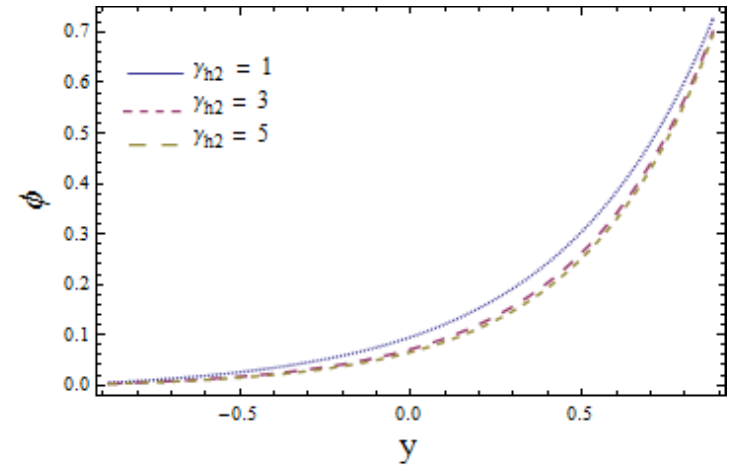
Figure 14. Mass concentration φ versus y for γ h 2 when (cid:101) = 0.2, τ ∗ = 2, x = 0.1, t = 0.1, γ h 1 = 6, γ m 1 = 6, γ m 2 = 8, γ = 1 and Sc = 2.